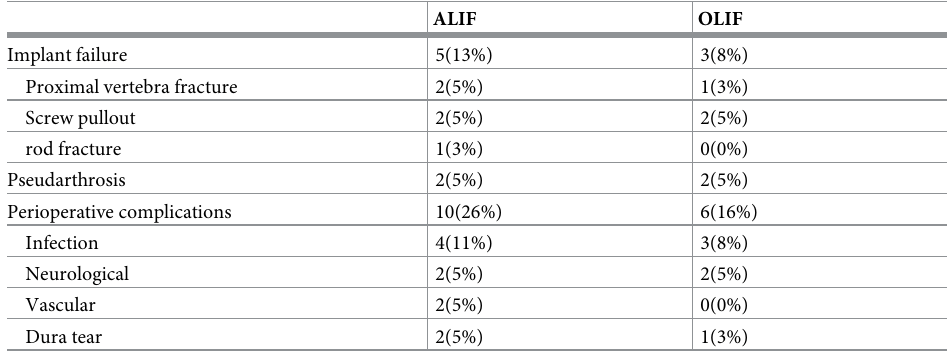
Table 4. Summary of